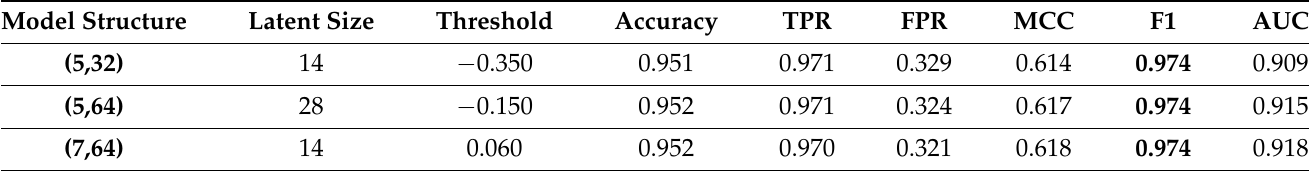
Table 9. The best performance for each model configuration. The best F1-score is in bold. Model Structure